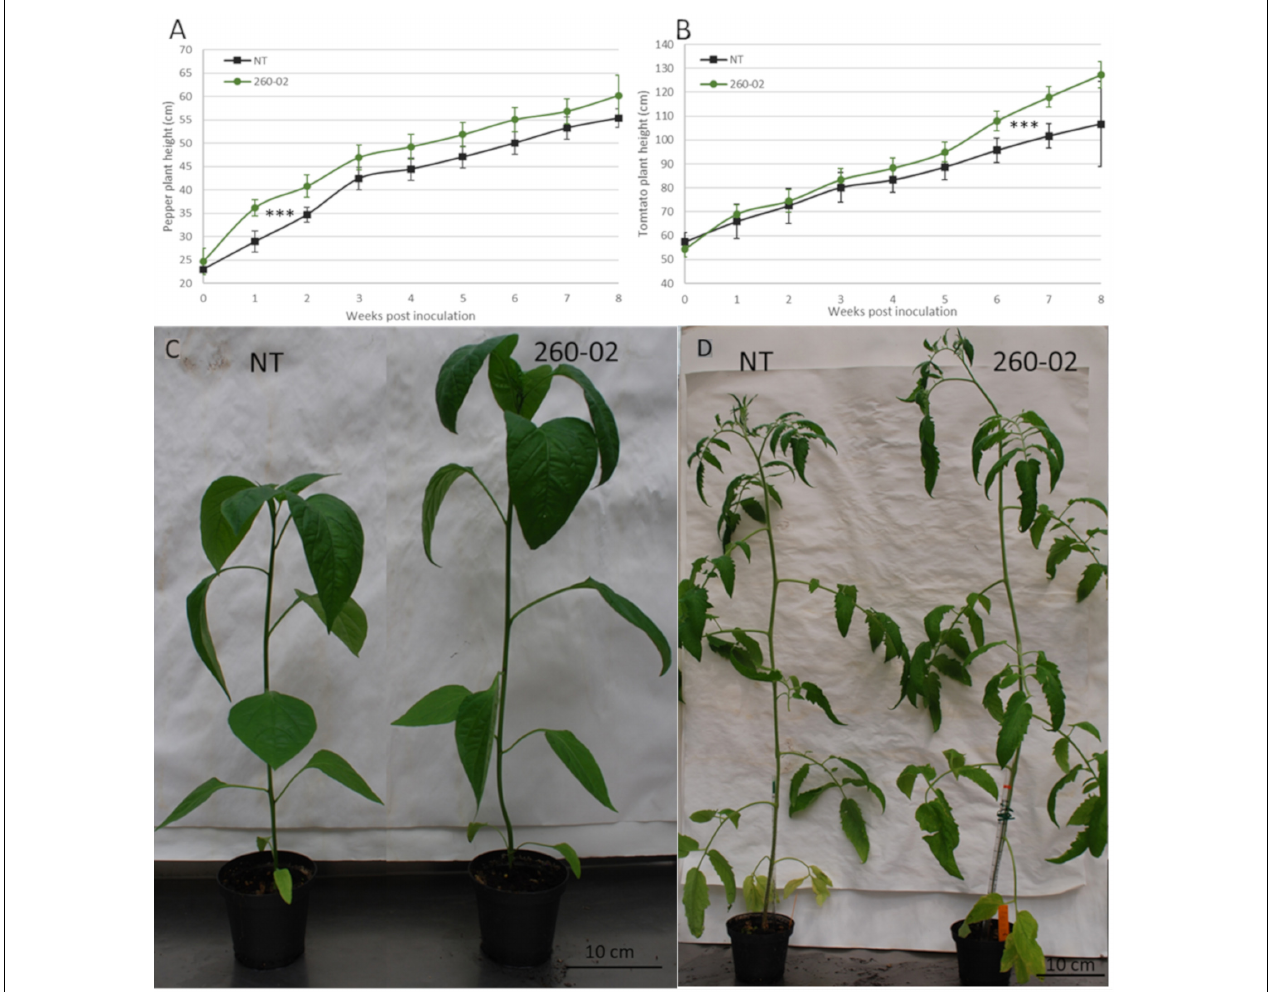
FIGURE 4 | Results of the in planta PGP assay. Graphs reporting the average height of the plants, 7 replicates per treatment, either non-treated (NT), or treated by root dipping with strain 260-02, for panel (A) pepper plants and for panel (B) tomato plants. The vertical axis reports the height in centimeters of the plants, while the horizontal axis reports the weeks from the treatment with the strain. The asterisks ( ∗∗∗ ) indicate that for both experiments, the progression of height throughout the 8 weeks found to be statistically different ( p < 0.001) according to a general linearized model test, optimized for repeated measures. On the lower side, pictures showing the non-treated and 260-02-treated plants of panel (C) pepper and panel (D) tomato one month after